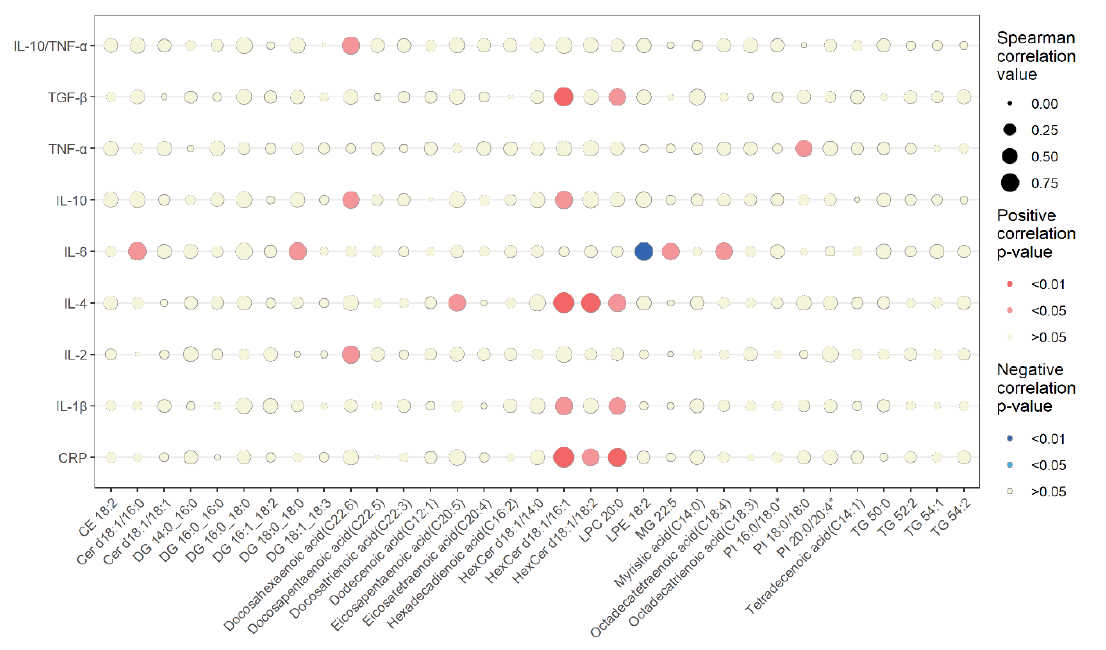
Figure 2. Spearman correlations between changes in differential serum lipids and inflammatory markers. The dot size represents the correlation value. The shade of the dot color represents significance (blue, negative correlation; red, positive correlation).